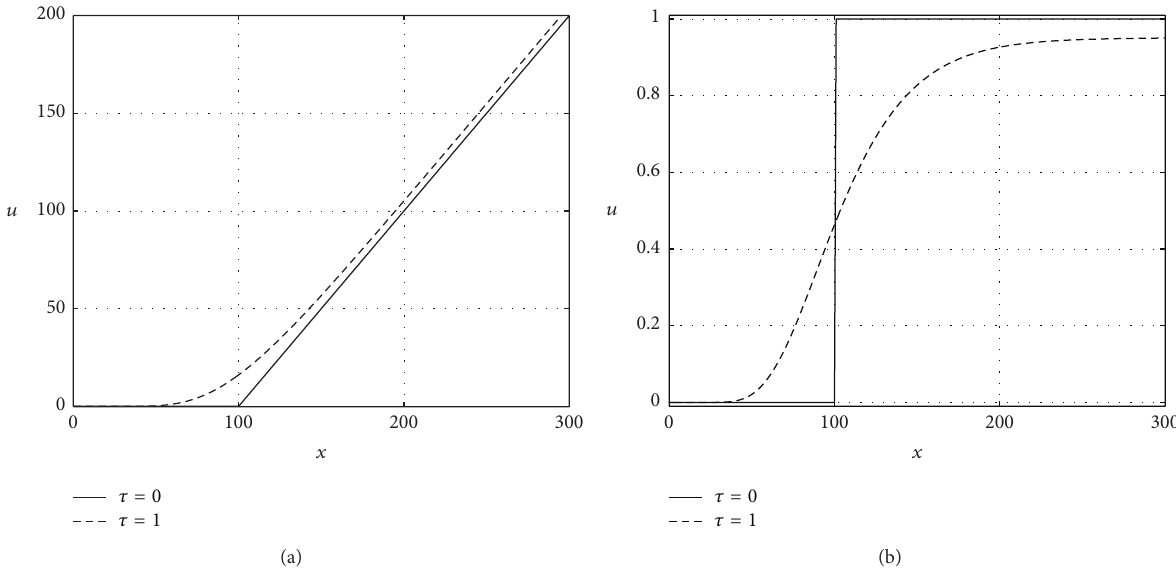
Figure 2: Values 𝑢(𝑥,𝜏) of (a) European call option and (b) cash-or-nothing option at 𝜏 = 0 and 𝜏 = 1 ,